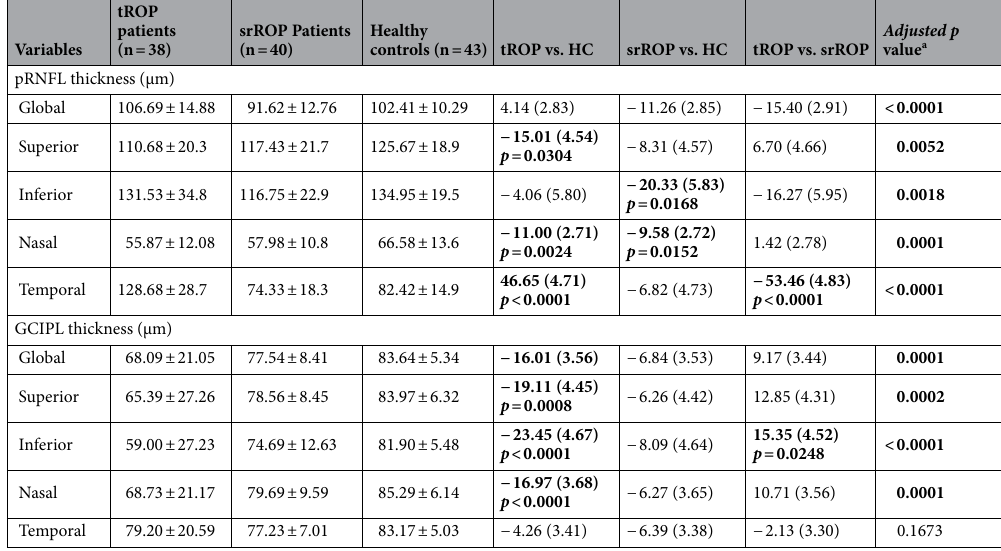
Table 2. Comparison of retinal layer thicknesses in preterm patients with a history of retinopathy of prematurity with treatment, spontaneously regressed, and full-term healthy controls. tROP, retinopathy of prematurity with laser treatment; srROP, spontaneously regressed retinopathy of prematurity; HC, healthy controls; pRNFL, peripapillary retinal nerve fiber layer; GCIPL, ganglion cell-inner plexiform layer; SE = standard error, CI = confidence interval. Values are shown as mean ± standard deviation. a P value was calculated by multivariate linear regression after adjusting for age and Bonferroni correction multiplied by 3 with 3 subgroups. In each group comparison, Bonferroni correction was performed by multiplying p value by 8 due to multiple testing of outcomes. Boldface indicates statistical significance.